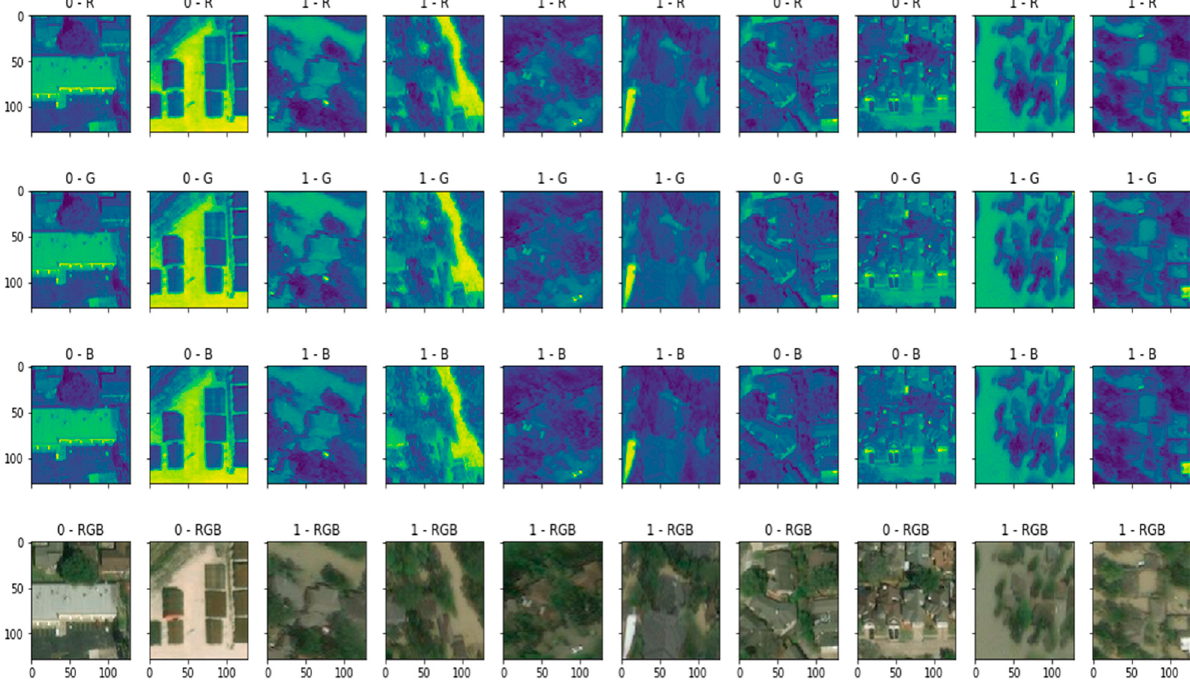
Figure 17. Information flow through filters of CNN layers.